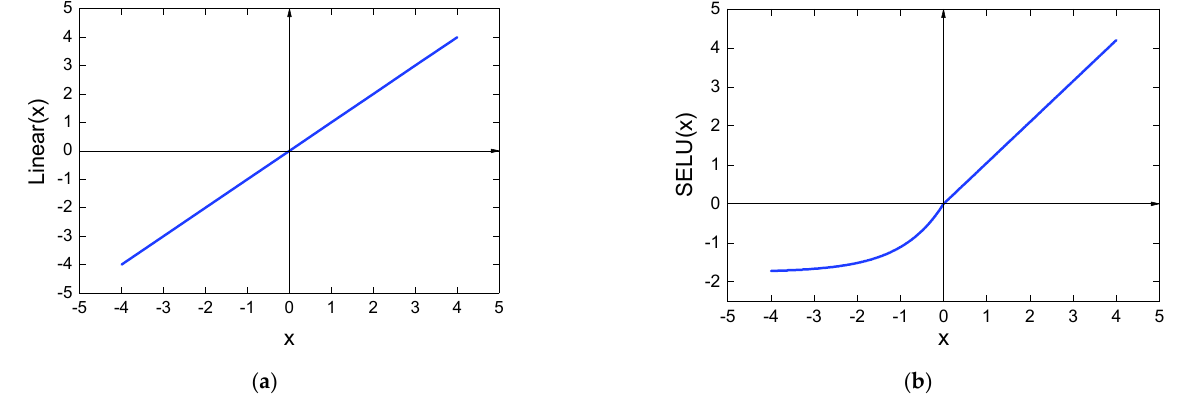
Figure 1. Linear and SELU activation functions: ( a ) Linear activation functions; ( b ) SELU activation functions.